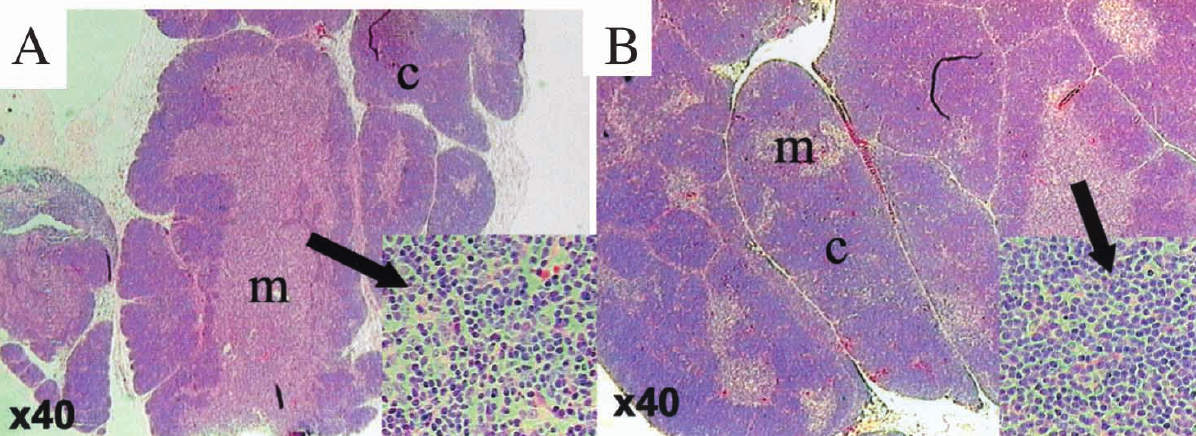
FIGURE 2 Expression of the HPV16E7 transgene in the K14E7 thymus causes gross architectural changes. Hematoxylin and eosin stain of formaldehyde-fixed sections from 6 month old FVB (A) and K14E7 (B) thymii. Expanded cortical regions (c) in the K14E7 thymus are accompanied by more densely packed medullary regions (m) as shown in expanded magnifications of medullary areas at the arrowheads (Magnification, £